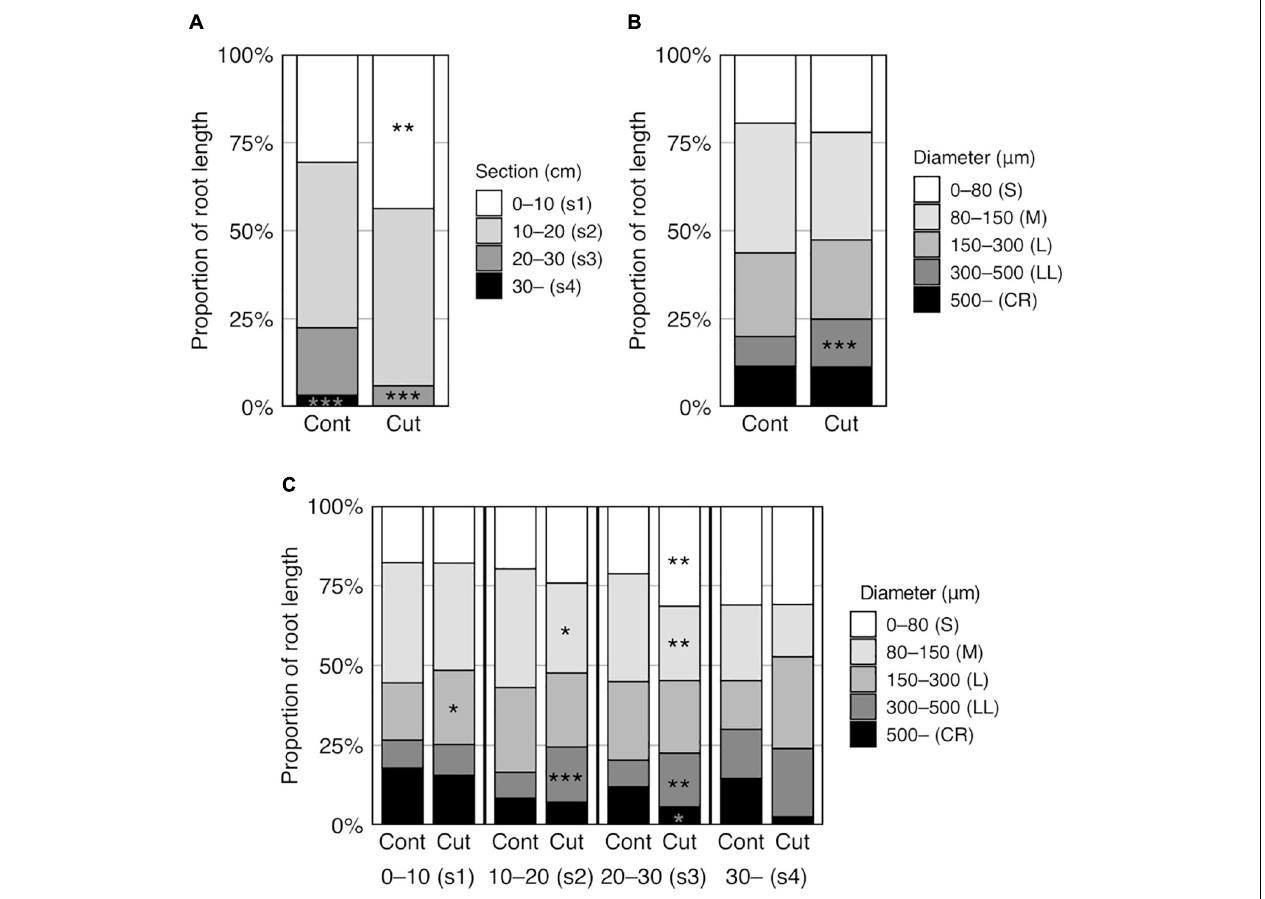
FIGURE 4 | Effect of root cutting treatment on root distribution in six rice genotypes grown in a semihydroponic phenotyping platform for 41 days after transplanting. (A) Proportion of RL in four sections. (B) Proportion of RL in five diameter classes. (C) Proportion of RL in five diameter classes in each section. Values represent means ( n = 28 and 23, Cont and Cut, respectively) (* p < 0.05; ** p < 0.01; *** p <